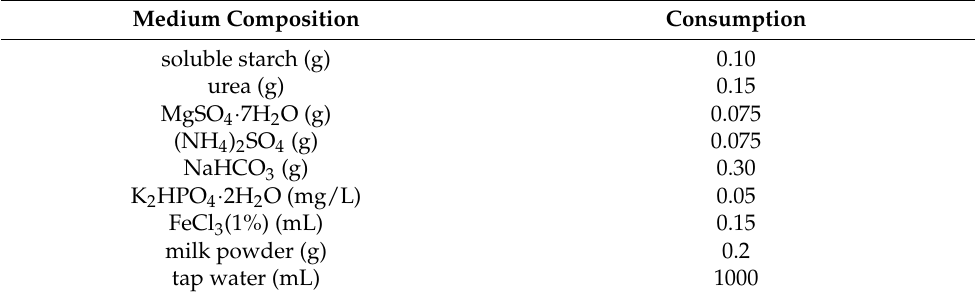
Table 1. The formula of synthetic wastewater.